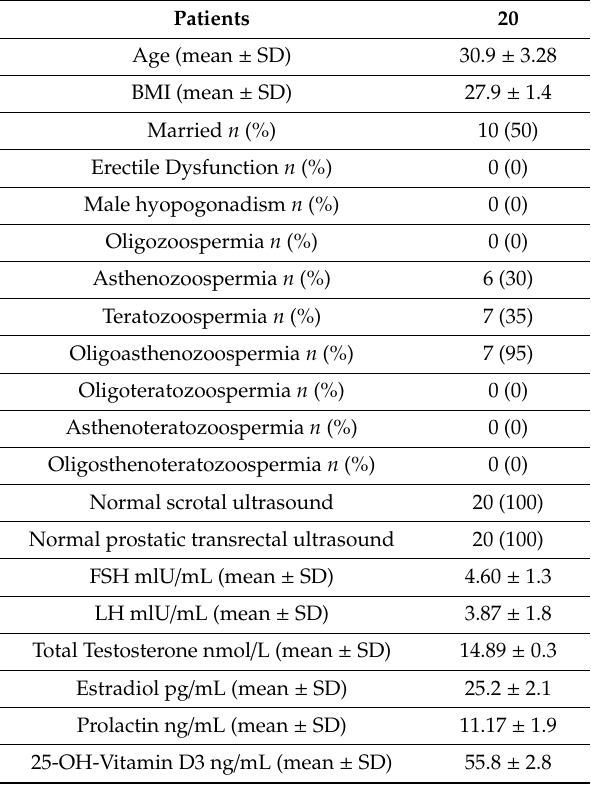
Table 1. The demographic and clinical characteristics of